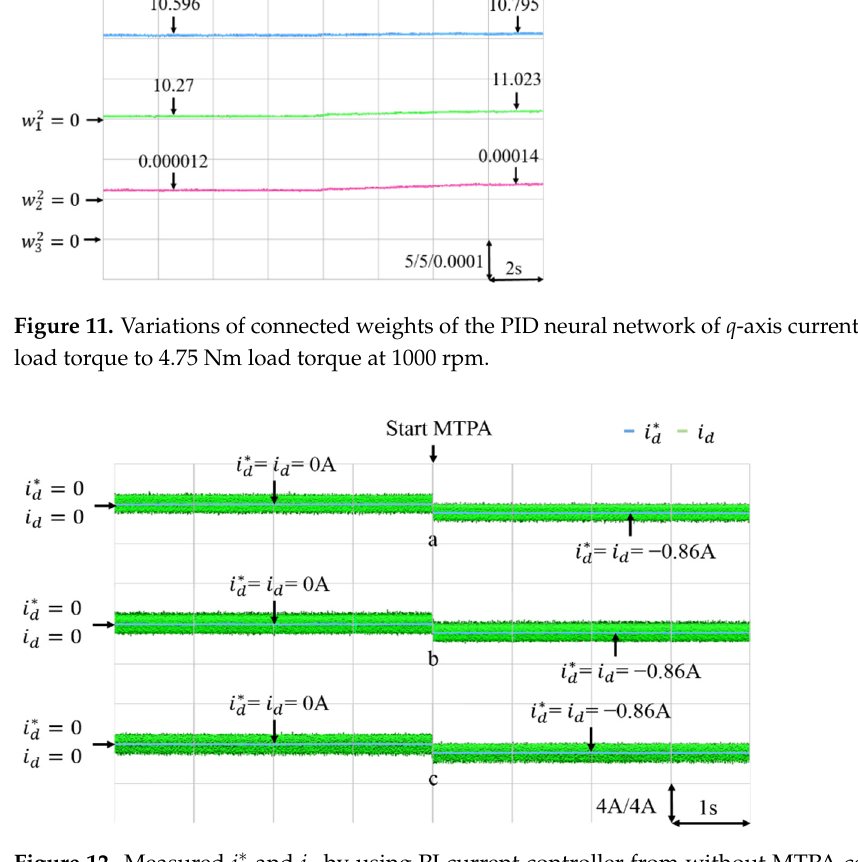
Figure 12. Measured i ∗ and i by using PI current controller from without MTPA control to with MTPA control at 1000 rpm with 4.75 Nm: ( a ) using PI current controller; ( b ) using PI-type SMC current controller; ( c ) using PID neural network current controller.